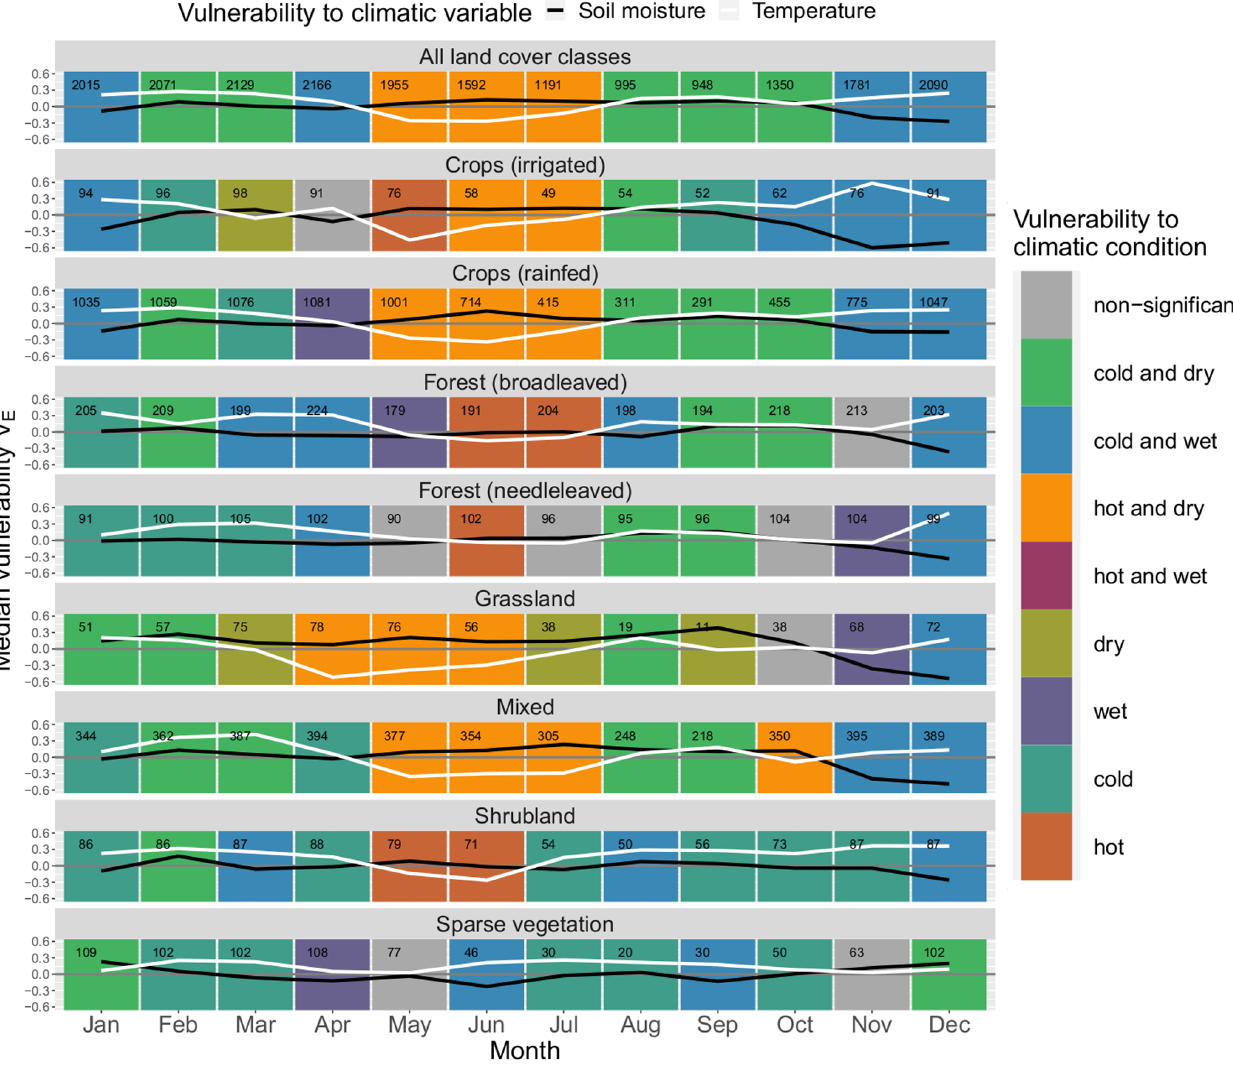
Figure A3. Median monthly ecosystem vulnerability per land cover. Vulnerability to temperature (ERA5-Land) is shown in white, and vulnerability to soil moisture (ERA5-Land at depth 7–28cm) is shown in black for each month of the year (columns) for each land cover (rows). Months with statistically significant deviation in climatic drivers during non-hazardous and hazardous ecosystem conditions according to the Mann–Whitney U test based on a significance level α = 0 . 05 are shown in colour (see legend); all other months are shown in grey. The number of grid points in which an event has occurred in this month and land cover within the period 1999–2019 is shown in the upper left corner of each